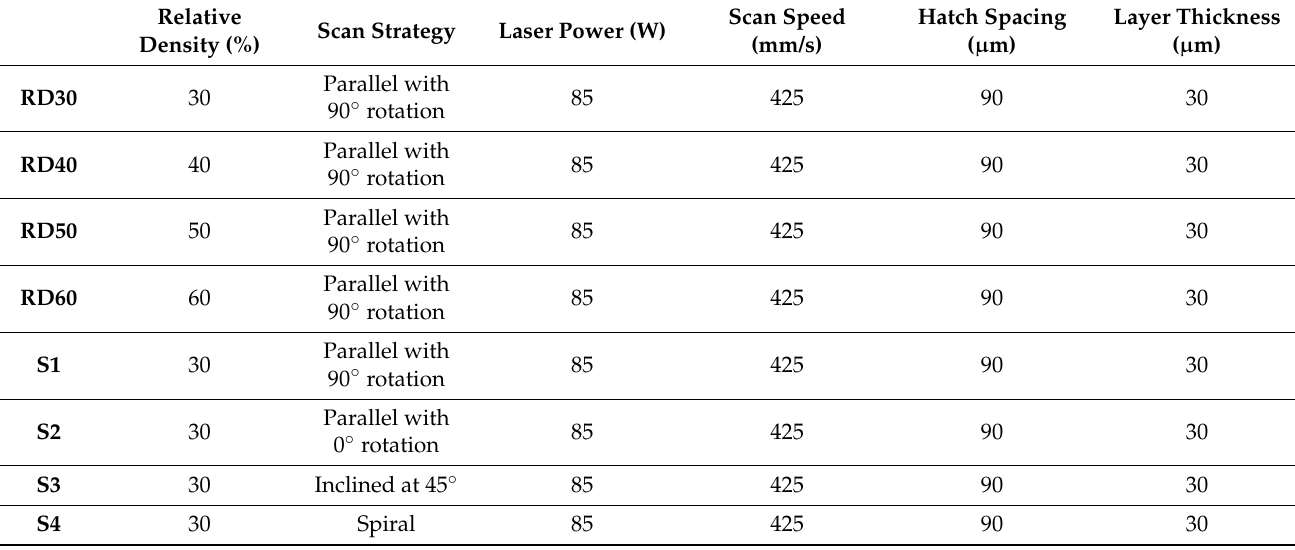
Table 1. Laser process parameters used during LPBF of primitive lattice